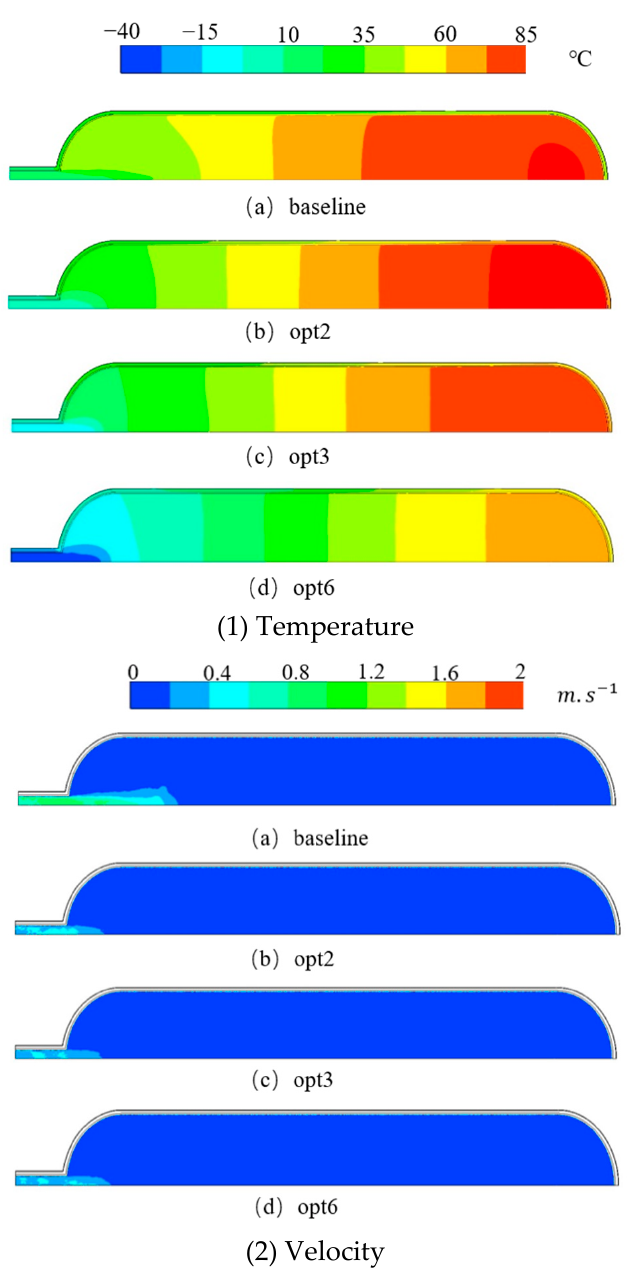
Figure 4. Temperature and velocity contour of hydrogen inside the cylinder at 90 s. It can also be observed from Figure 4 that the temperature distribution inside the cylinder is uneven under various working conditions, showing a downward trend from the tail to the mouth of the cylinder (pictured from right to left). In Figure 5, the highest temperature rise curve is combined with the average temperature rise inside the cylinder. The main reason is that the inlet hydrogen temperature is low, resulting in a long time for the injected hydrogen to flow from the bottle mouth to the bottle tail region. This makes the high-temperature gas in the bottle tail region unable to conduct sufficient convective